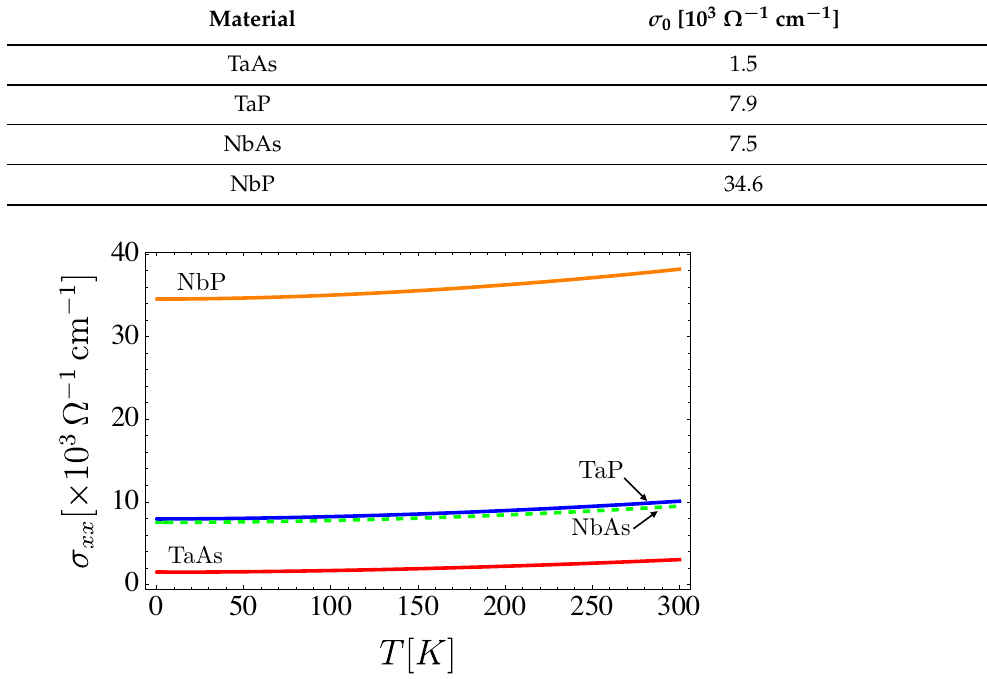
Figure 7. A comparison of the total conductivity versus temperature behavior for the transition metals’ monopnictides TaAs, TaP, NbAs and NbP. Here, we use a concentration of dislocations of n d = 10 11 cm − 2 .